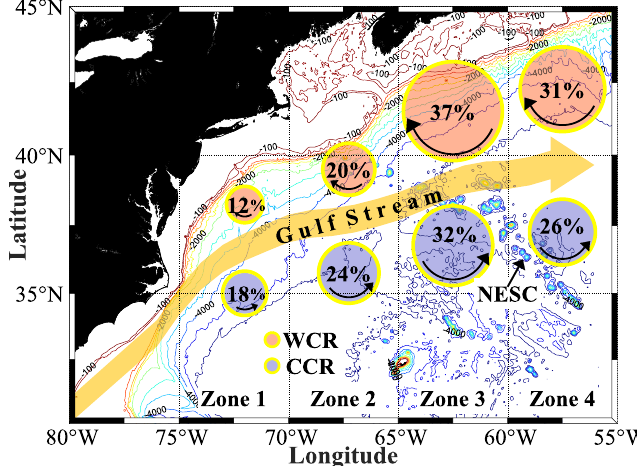
Figure 1. Geographic distribution of Warm and Cold Core Ring formation during 40 years of study (1980– 2019). The four different zones within the 75 ◦ – 55 ◦ W region are: Zone 1: 75 ◦ – 70 ◦ W ; Zone 2: 70 ◦ – 65 ◦ W ; Zone 3: 65 ◦ – 60 ◦ W ; Zone 4: 60 ◦ – 55 ◦ W . A total of 1014 Warm Core Rings and 1023 Cold Core Rings were documented over the 40-year period. Percentages represent the number of Warm (Cold) Core Rings that are formed in that zone compared to total number of Warm (Cold) Core Rings. The map was generated using the MATLAB M_Map package 16 with topography contours from ETOPO1 17 and the coastline from Global Self-consistent, Hierarchical, High-resolution Geography Database (GSHHG) 18 .